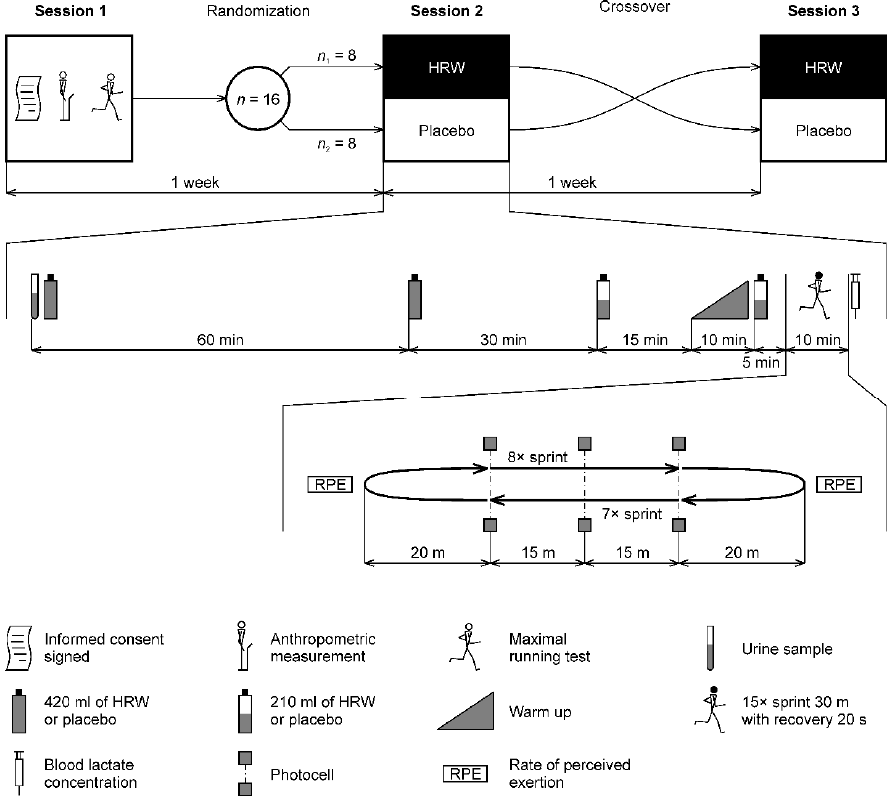
Figure 1. Overview of the study protocol and labeling of sessions. HRW—hydrogen-rich water.